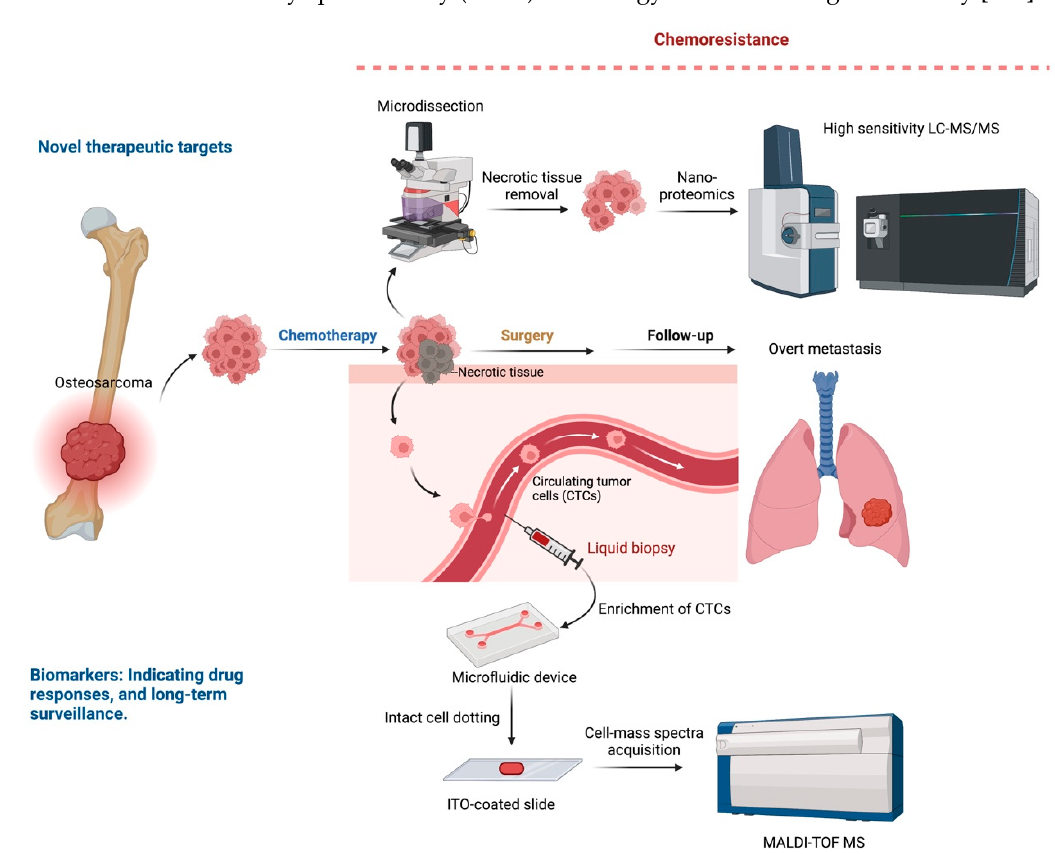
Figure 2. Future perspectives for the use of MS-based technology in novel target and biomarker discovery in osteosarcoma.